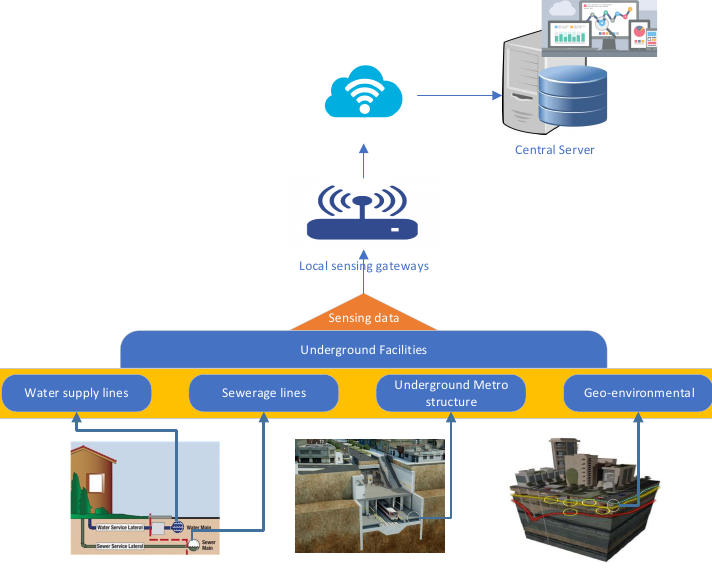
Figure 1. Conceptual design of underground risk assessment